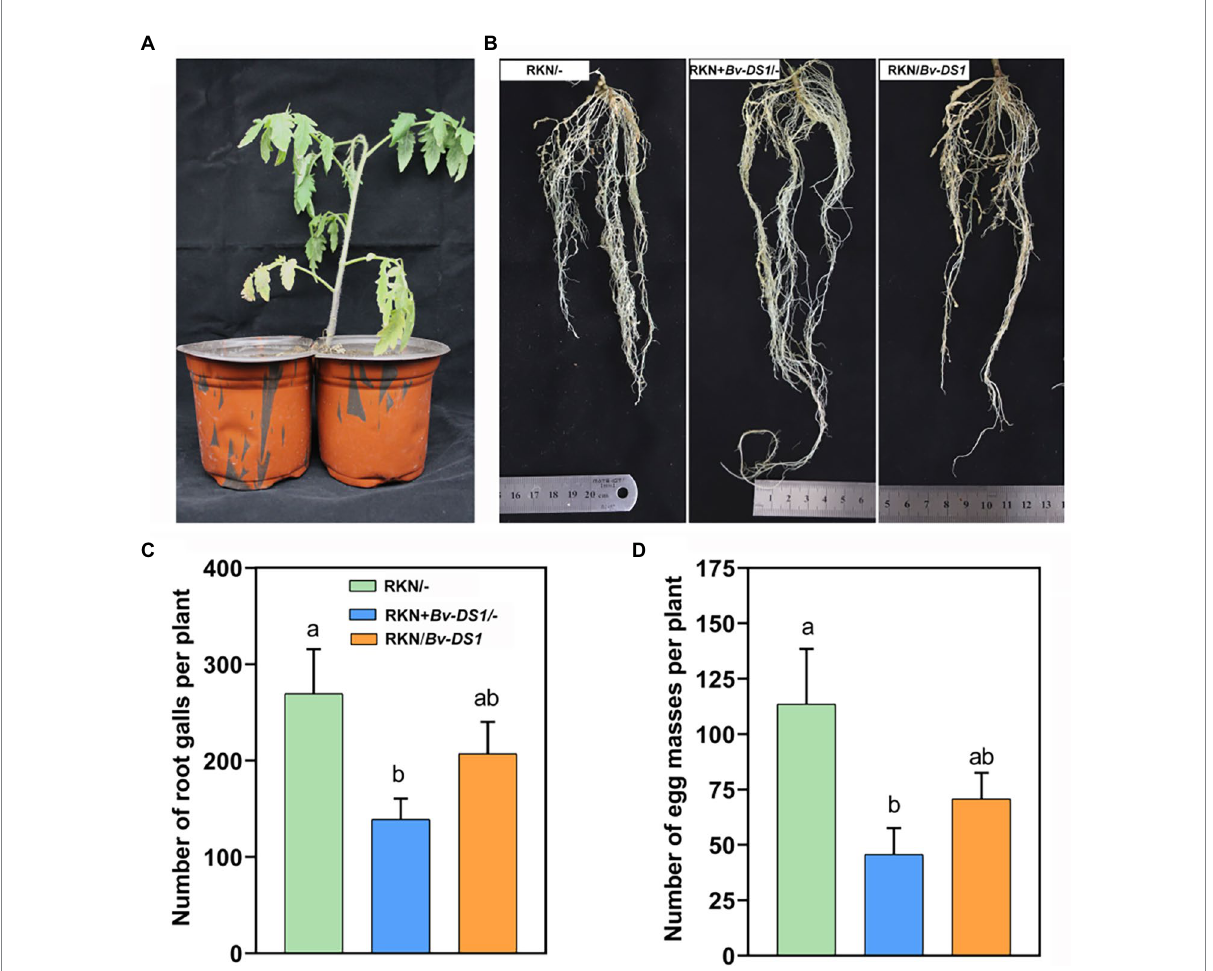
FIGURE 5 Bacillus velezensis YS-AT-DS1 ( Bv-DS1 ) induced the local resistance of tomato plants to M. incognita in the split-root assay. (A) The split-root system of tomato growth in two adjacent pots. (B) Less root galls were observed in tomato plants with half of roots inoculated with Bv-DS1 and RKN together (RKN + Bv-DS1 / − ) compared to other treatments (RKN/ − ; RKN/ Bv-DS1 ). (C) The number of galls was counted at 35 dai in the split- root system. Data are shown as mean ± SE of six plants for each treatment. Different letters indicate significant differences between treatments ( p < 0.05) according to Tukey’s multiple comparisons test following one-way ANOVA. (D) Number of eggs per egg mass. Data are presented as mean ± SE of six plants for each treatment. Different letters indicate significant differences between treatments ( p < 0.05) according to Tukey’s multiple comparisons test following one-way